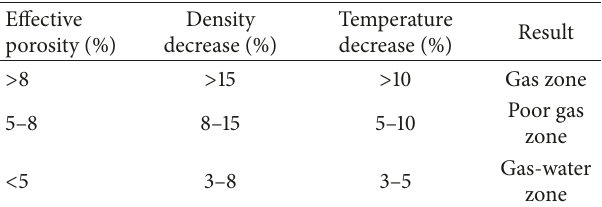
Table 1: Evaluation criteria for gas